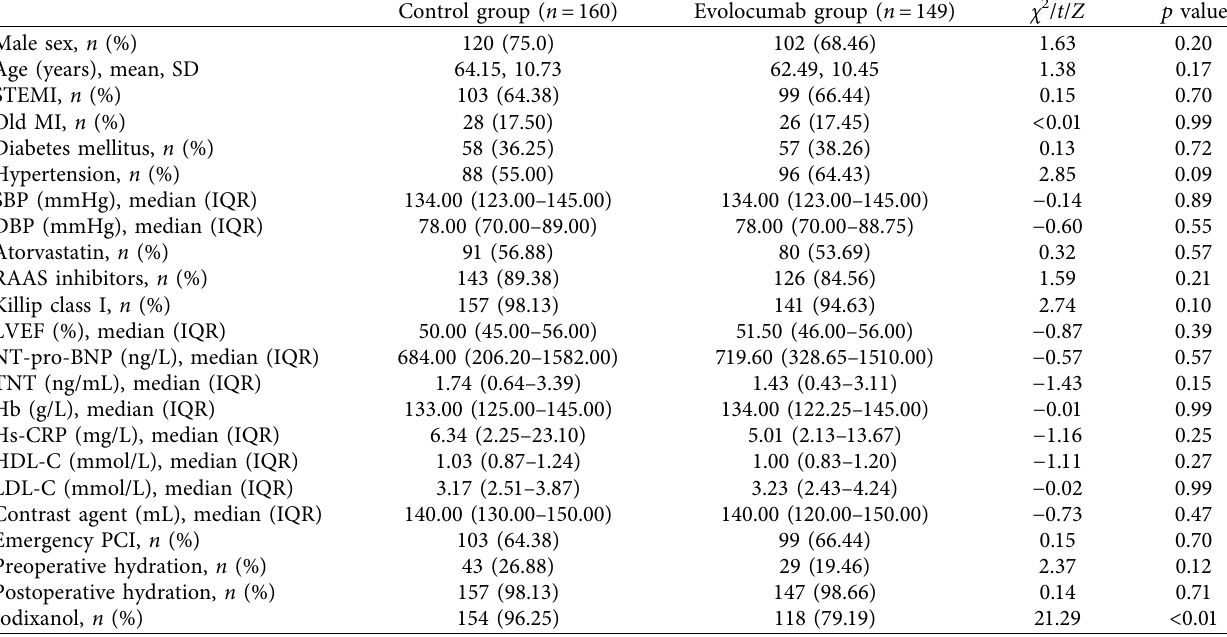
Table 1: Comparison of baseline data between those who received evolocumab and controls.